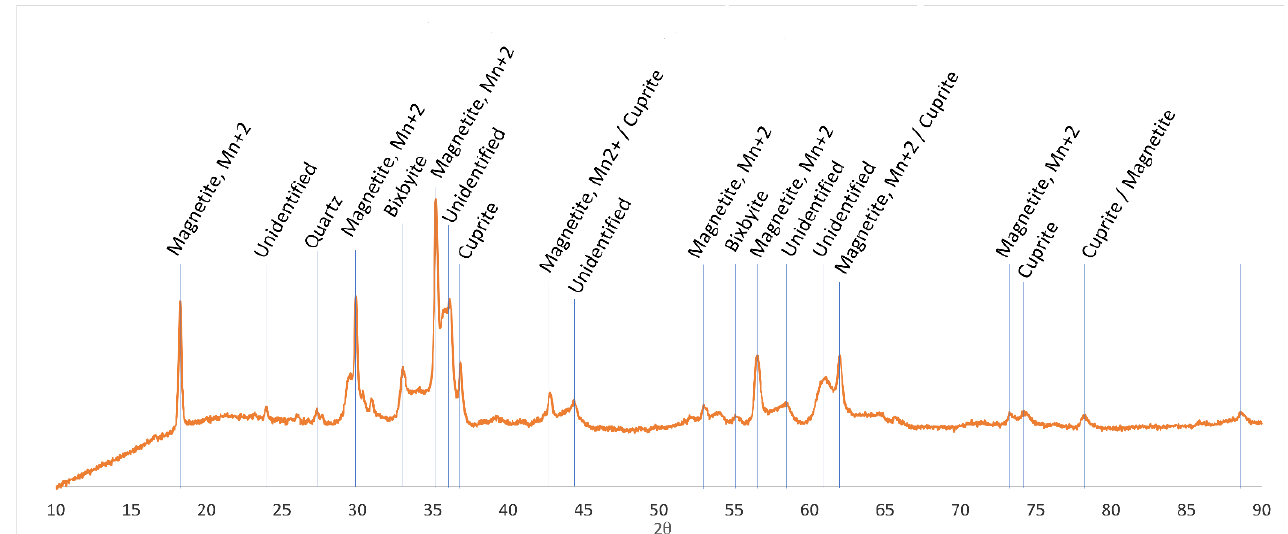
Figure 7. The XRD pattern of calcined PMMN with the identified peaks.